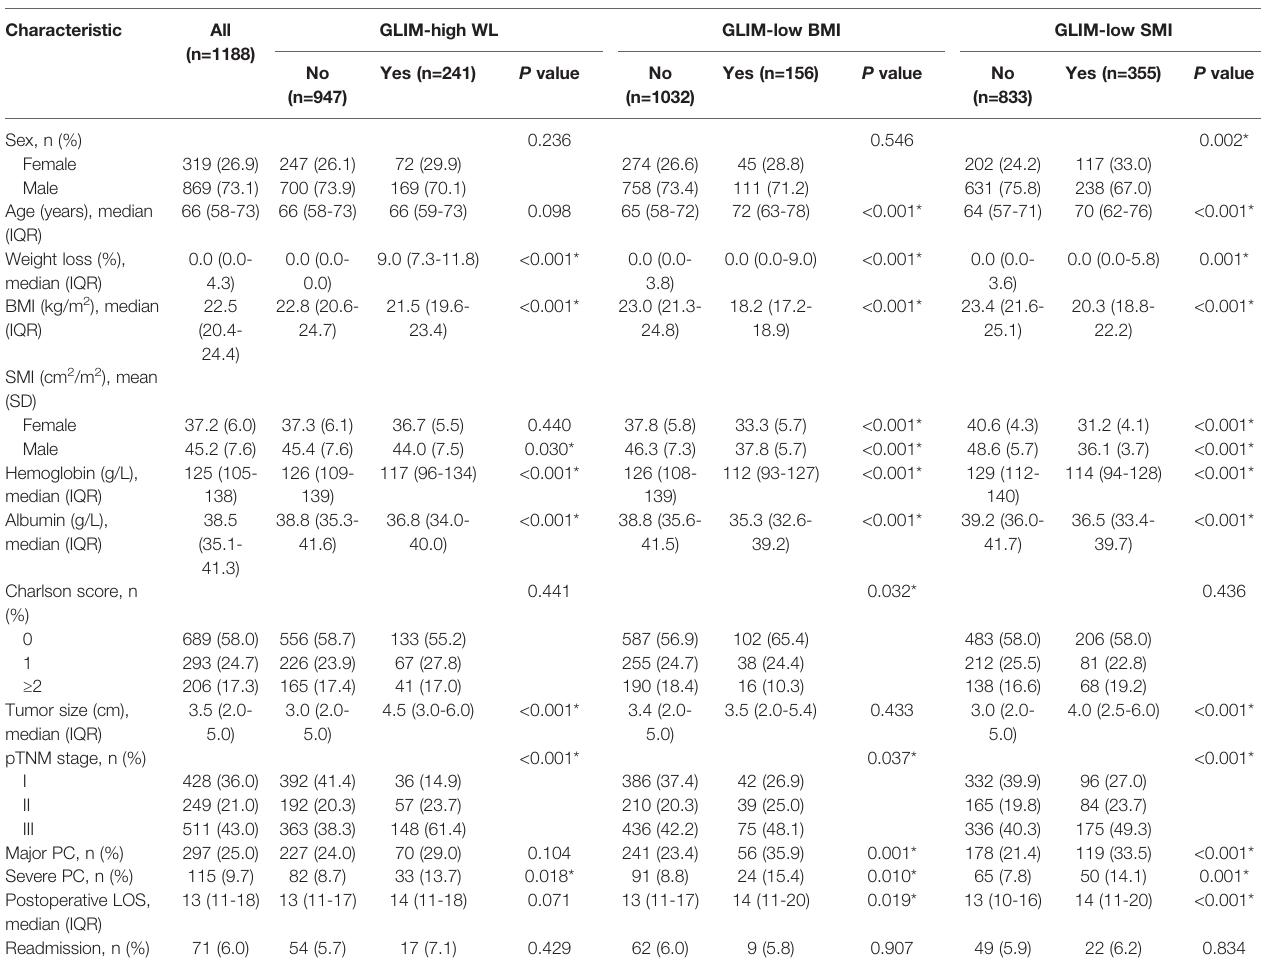
TABLE 1 | Patient baseline characteristics in the entire cohort.